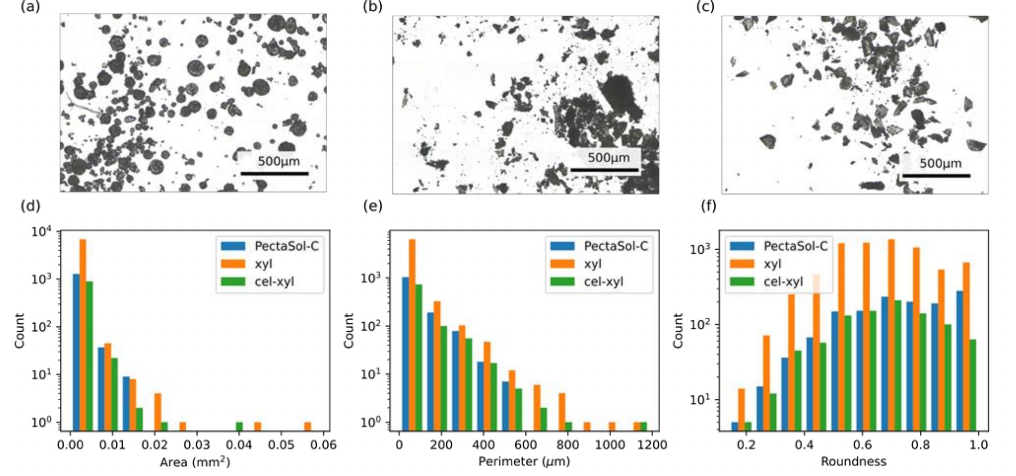
Figure 1. Comparison of pectin morphology ( a ) PectaSol-C, ( b ) xylanase, ( c ) cellulase and xylanase. Histograms of ( d ) surface, ( e ) perimeter, and ( f ) roundness of analyzed samples.